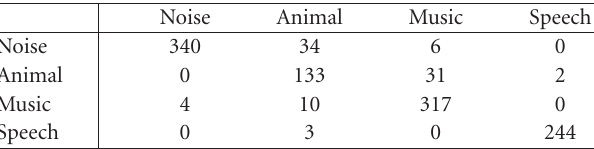
Table 8: Confusion matrix (rows give the decision and columns give the true class) for RSF short with NN. This gave an accuracy of